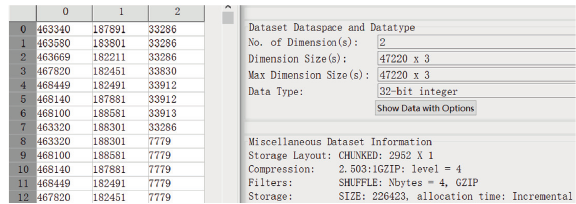
Figure 10: Regular vertex storage in HDF, with 2.503 compression ratio and 47220 vertices.